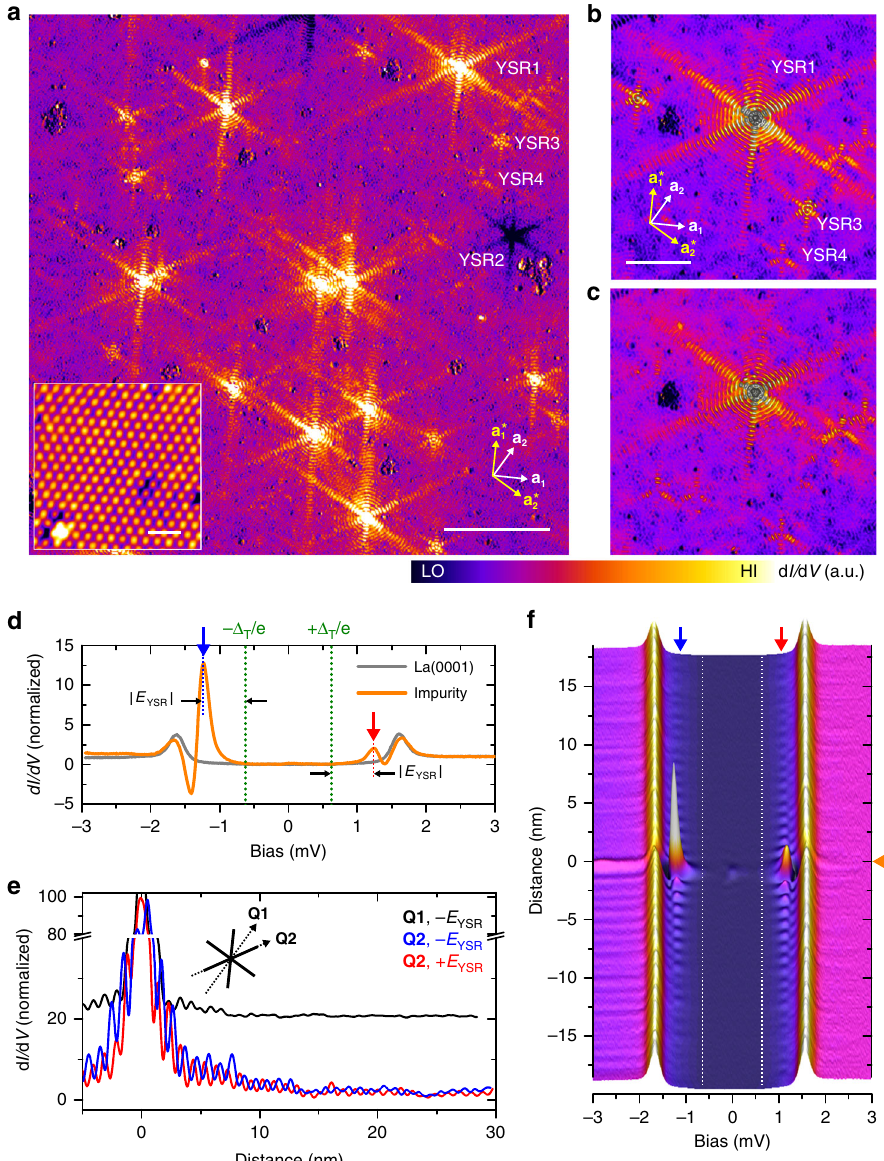
Fig. 1 Anisotropic long-range modulation of Yu – Shiba – Rusinov (YSR)- bound states around magnetic impurities on a superconducting La(0001) surface. a Differential tunneling conductance ( dI / dV ) map showing star-shaped LDOS modulations of the YSR bound states around magnetic atoms. Tunneling parameters: I T = 1.0 nA, V S = − 1.2 mV, 150 × 150 nm 2 , scale bar: 30 nm. (Inset: Atomically resolved STM constant-current image. Scale bar: 1.0 nm). The white arrows, a 1 ( a 2 ) and the yellow arrows, a 1 *( a 2 *) denote the lattice vector directions on the La(0001) surface extracted from the STM image and the corresponding reciprocal lattice vectors, respectively. b , c Zoomed-in dI / dV maps for an isolated magnetic atom YSR1 (white arrow in a ) showing oscillatory beam-like extensions of the YSR bound state at b V S = − 1.2 mV and c V S = + 1.2 mV, 60 × 60 nm 2 , I T = 1.0 nA, scale bar: 15 nm. d Tunneling spectra measured on a single magnetic impurity (orange) and on the La(0001) surface (gray). A superconducting La-coated PtIr tip with a gap size of Δ T = 0.65 meV was used for taking STM images and differential tunneling conductance maps. A pair of the YSR bound states is indicated by red and blue arrows at ±| Δ tip + E YSR | with E YSR = 0.55 meV (black arrows). e Differential tunneling conductance pro fi les taken across the center of a magnetic atom along two different directions, Q1 and Q2 , as depicted in the inset. The pro fi le along Q1 is plotted with an offset for clarity. f One-dimensional tunneling spectroscopic map across the YSR1 impurity along the Q2